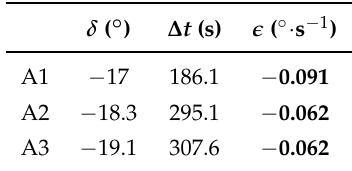
Table 9. Associations of the Walk Shown in Figure